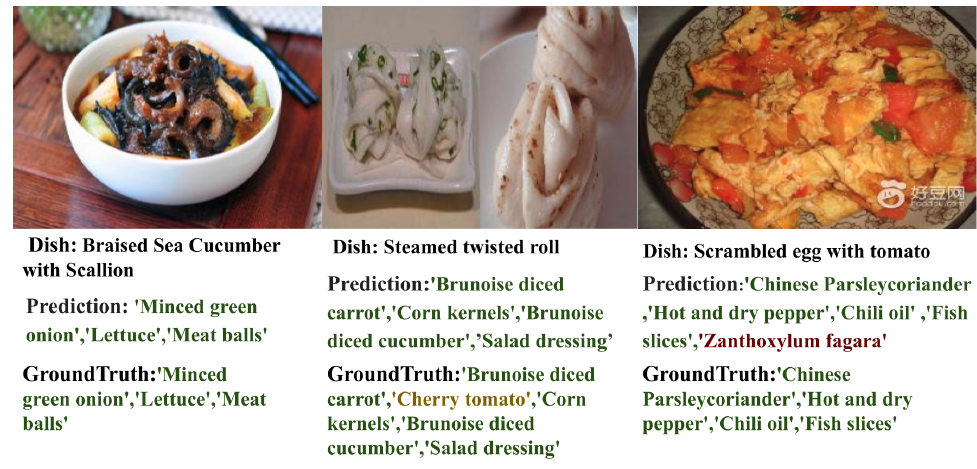
Figure 21. Results of ingredient detection on randomly selected images from the VireoFood- 172